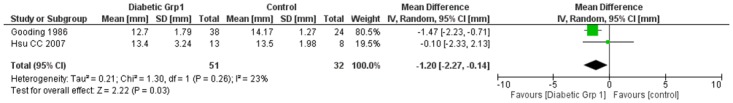
Meta-analysis and forest plot for sub-metatarsal head 2 unloaded total soft tissue depth, non-diabetic and diabetic group 1.